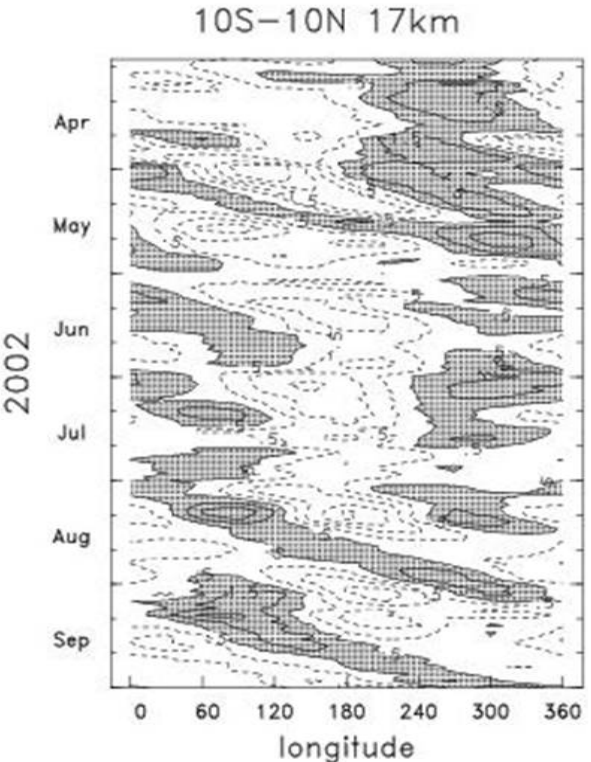
Fig. 12. Kelvin wave variability near the equatorial tropopause observed in CHAMP GPS radio occultation